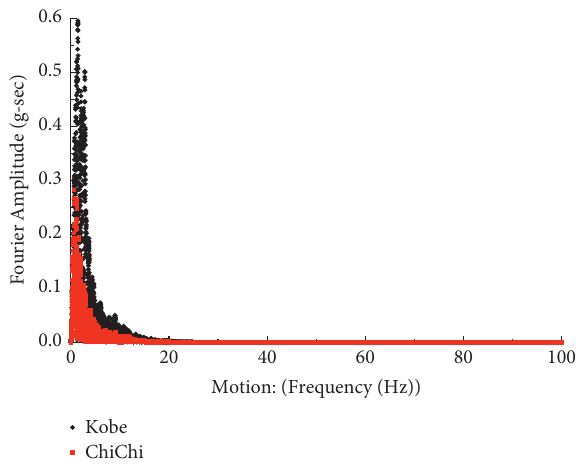
Figure 5: Fourier amplitude spectrum of input motions.